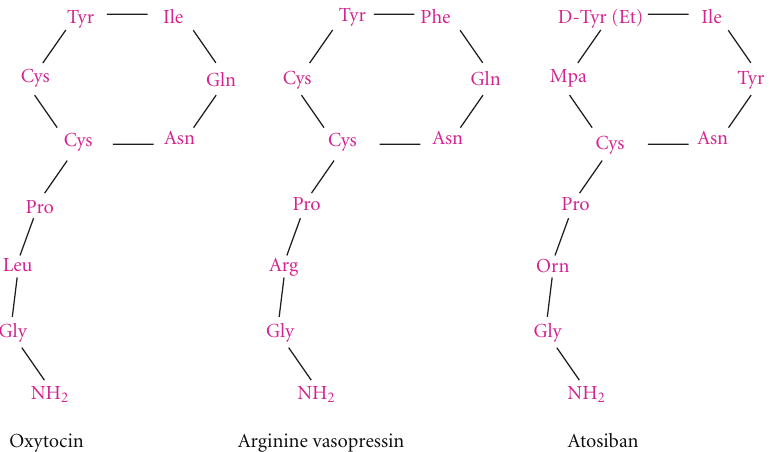
Figure 2: The structure of oxytocin, arginine vasopressin, and